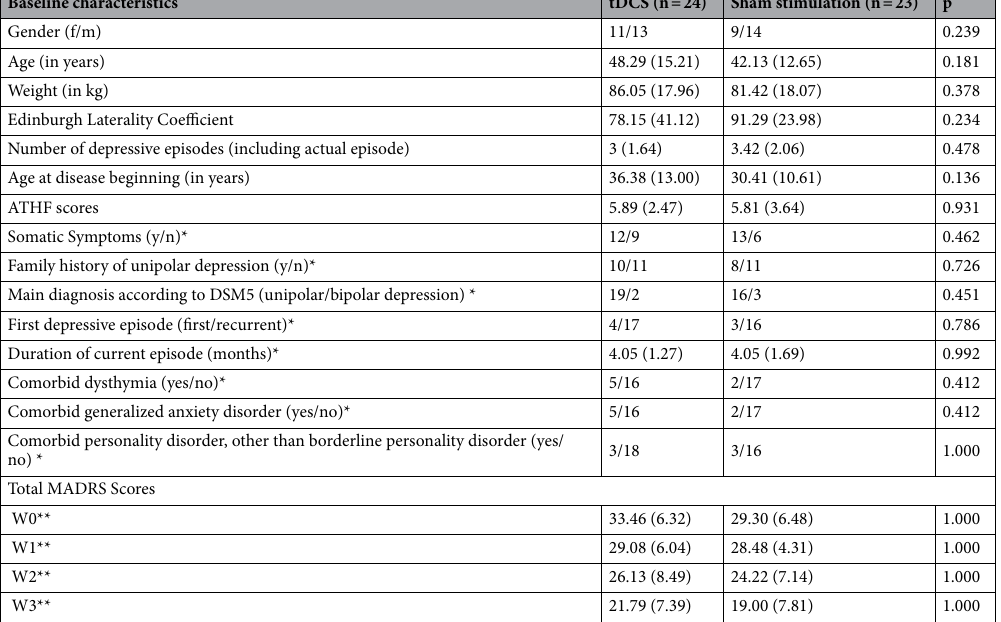
Table 2. Characteristics of the participant groups. Values are expressed as mean (standard deviation). W0, first stimulation; W1, one week after first stimulation; W2, two weeks after first stimulation; W3, three weeks after first stimulation; ATHF, Antidepressant treatment history form; DSM-5, Diagnostic and Statistical Manual of Mental Disorders, fifth version; MADRS, Montgomery–Åsberg depression rating scale; tDCS, Transcranial direct current stimulation. *Of the 47 patients included in the study, 40 completed the three-week treatment, and seven dropped out of the study before finishing the trial. Hence, data of 4 participants of the sham stimulation group and 3 of the tDCS are missing. **p-values are